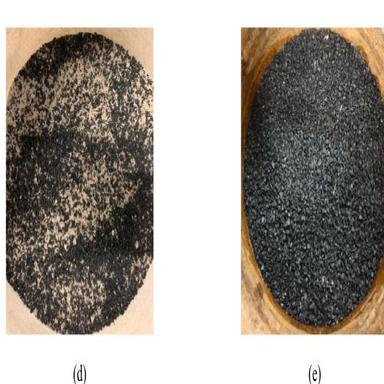
Sand and sand-tyre mixes (a) Sand (b) Sand with 10 % tyre rubber (c) Sand with 20 % tyre rubber (d) Sand with 30 % tyre rubber (e) tyre crumb.